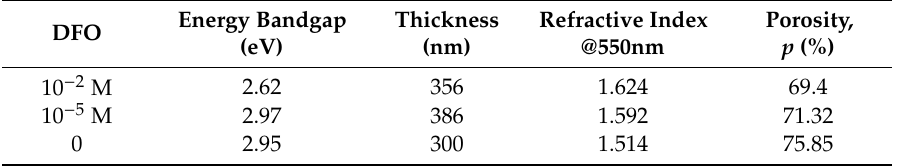
Table 2. The SE-estimated properties of DFO/TiO 2 films versus different concentrations of DFO dye.